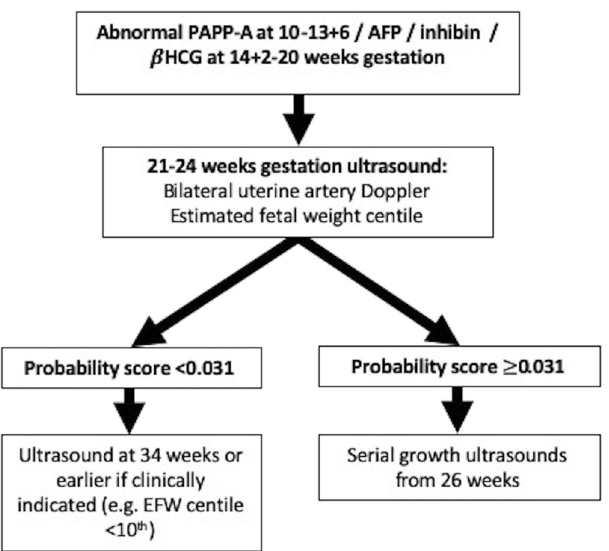
Figure 4. Suggested care algorithm for women with abnormal serum biomarkers (PAPP-A ≤ 0.415 MoM, βHCG ≥ 4.0, MoM, inhibin ≥ 2.0 MoM and αFP ≥ 2.2